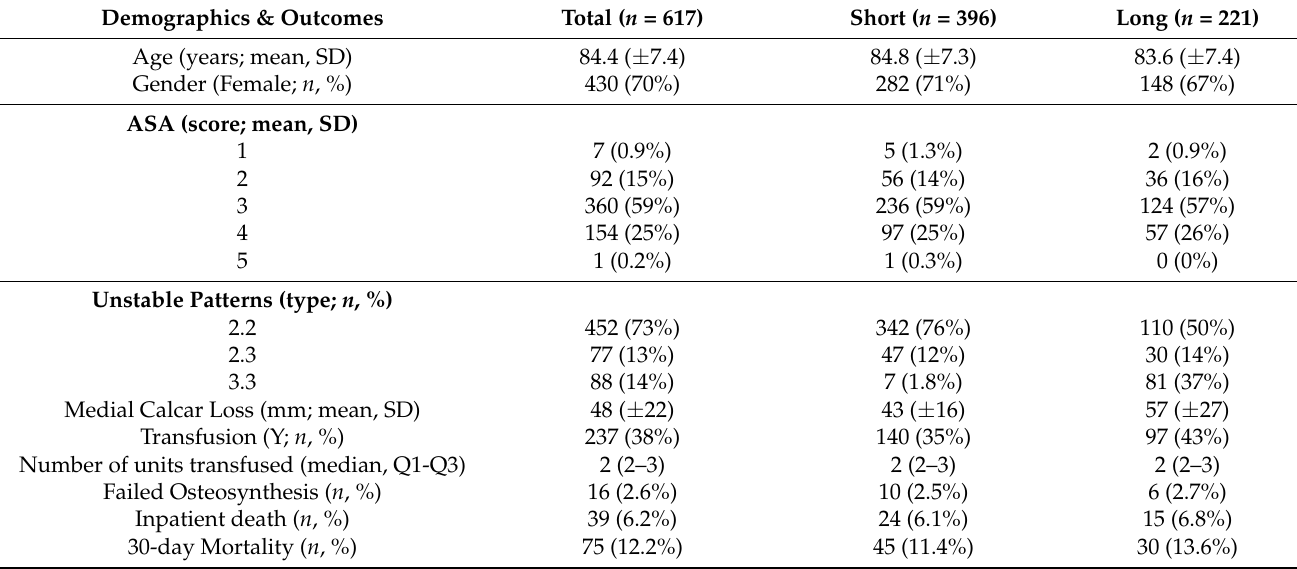
Table A1. Demographics and Outcomes of